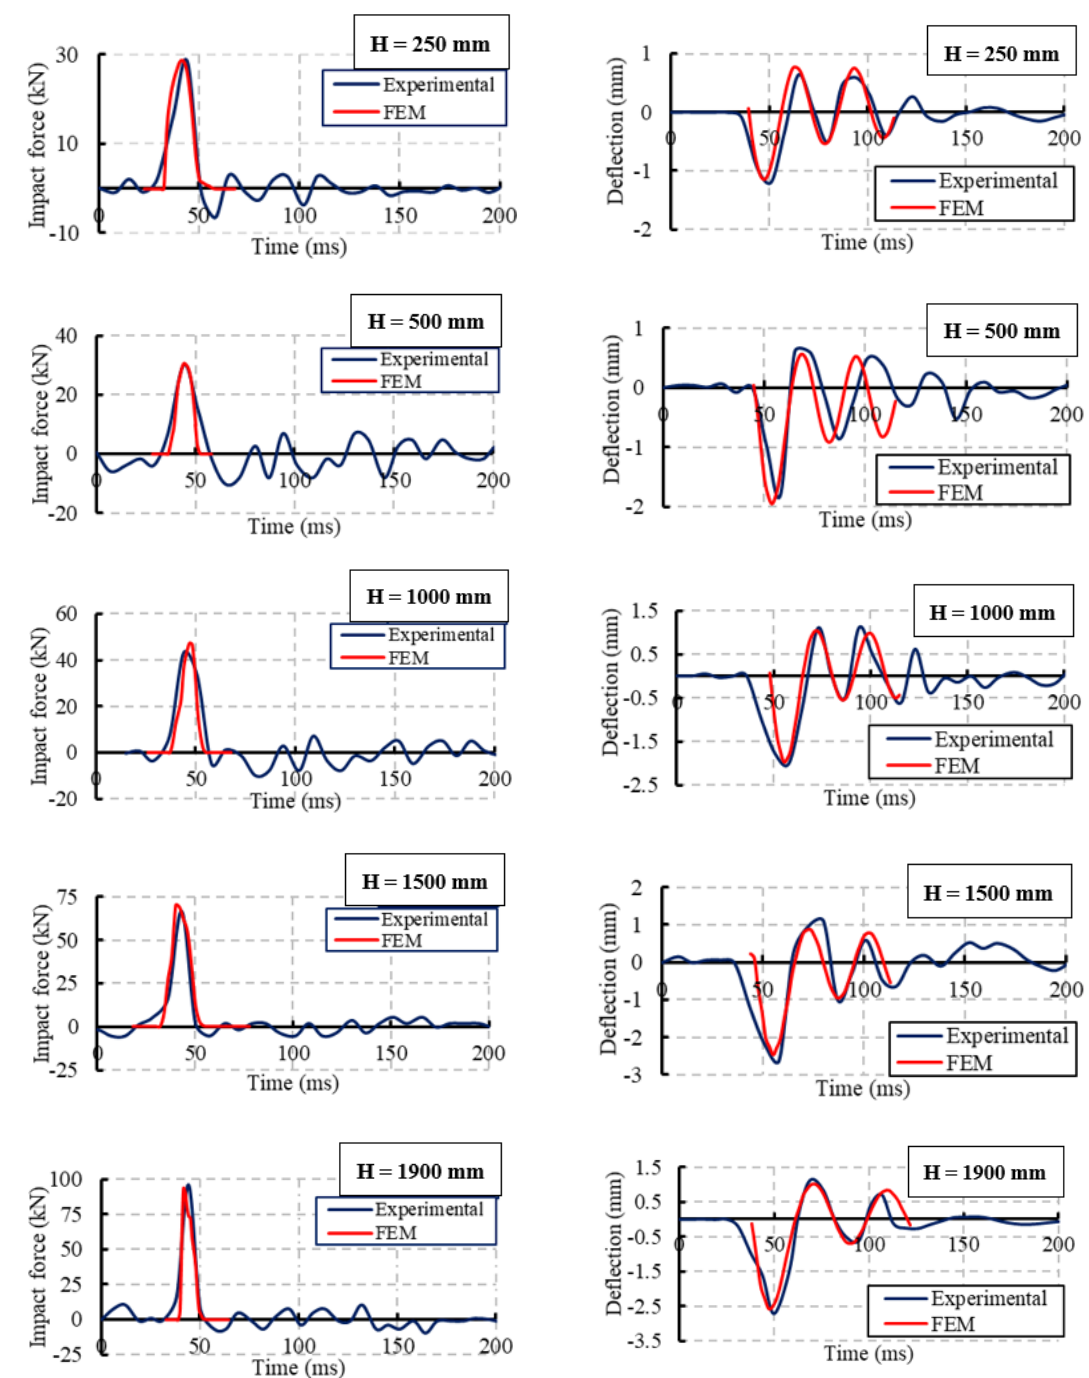
Figure 18. Validations of the experimental and FE results of the impact force and mid-span deflection time histories for specimen NR ‐ I.